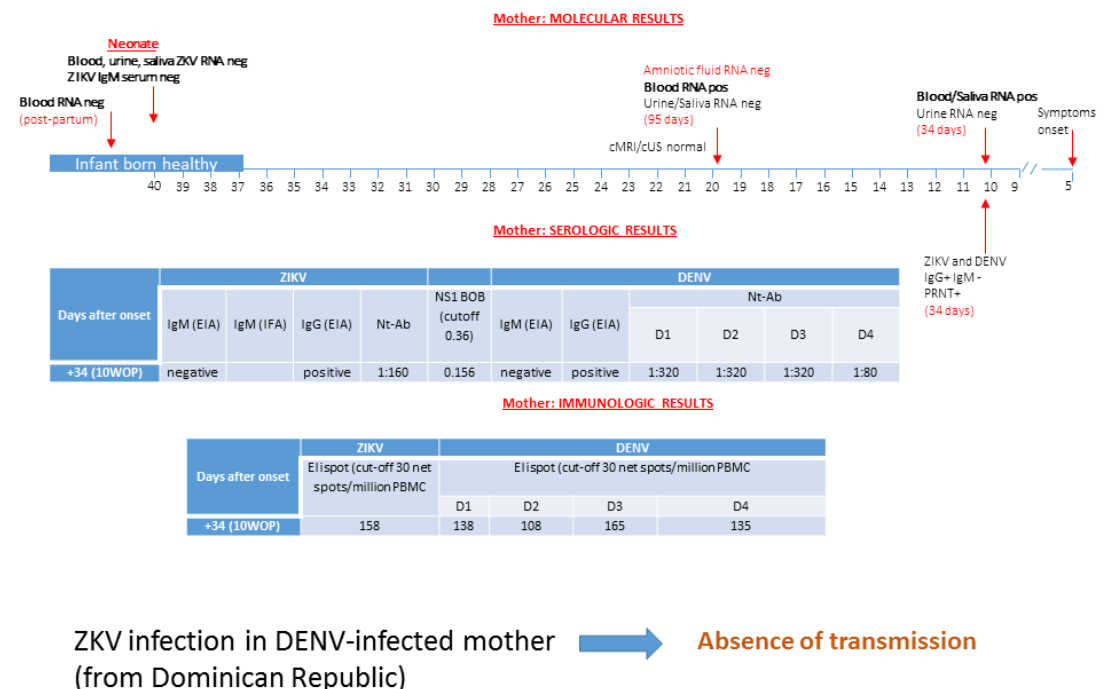
Figure 3. Diagnosis by molecular, serological, and immunological assays of ZIKV infection in a DENV-infected pregnant woman from Brazil was performed. No transmission was reported. cMRI / cUS: cerebral magnetic resonance imaging / cerebral ultrasonography; PRNT: plaque reduction neutralization test; WOP: week of pregnancy; EIA: enzyme immunoassay; IFA: immunofluorescence assay; Nt-Ab; neutralizing antibodies. In the box of molecular diagnosis, black numbers specify the week of pregnancy, while red numbers in brackets indicate the exact day of gestation. BOB assay result is expressed as the ratio of inhibition, while ELISpot assay is measured as net spots / million PBMC.